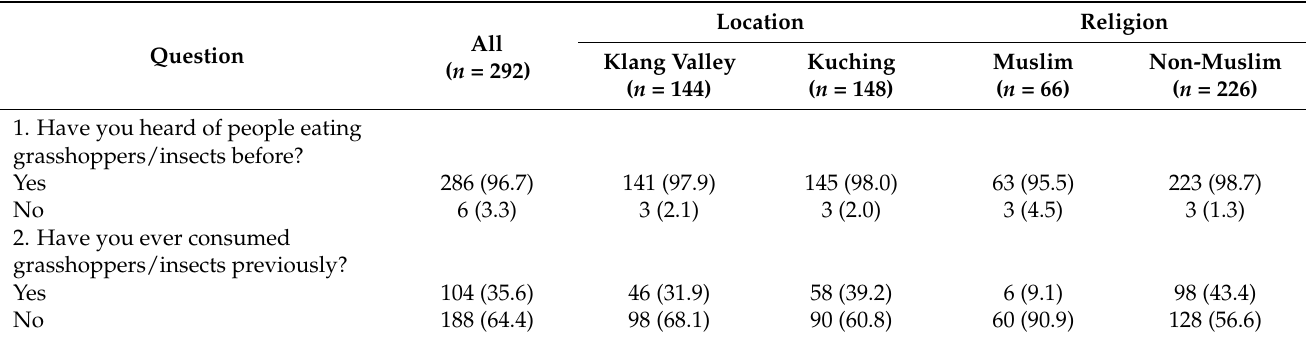
Table 2. Awareness and experience of eating grasshoppers or other insects as food, n